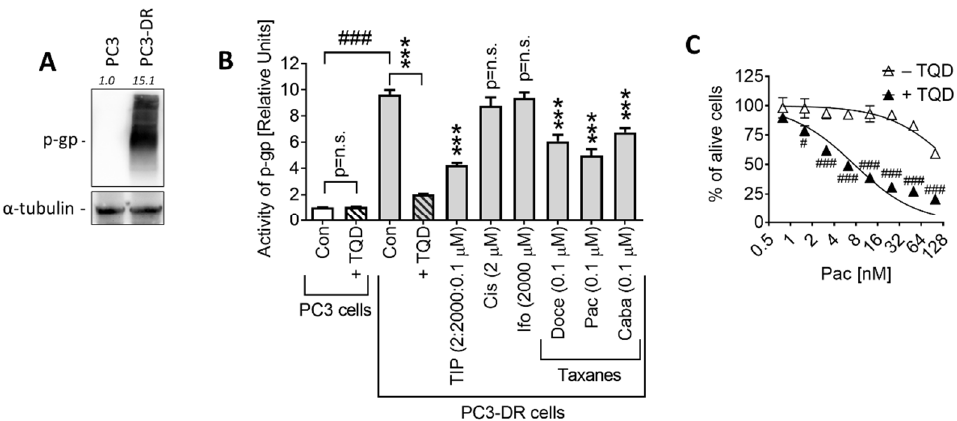
Figure 5. P-gp expression and activity. ( A ), p-gp expression in PC3 and PC3-DR cells was evaluated with Western blotting. ( B ), Effect of the investigated drugs and TIP combinations on the activity of p-gp in PC3-DR cells measured using calcein-AM efflux assay. The observed drop-down of p-gp activity indicates the efflux of the drugs via the p-gp system. ( C ), Viability of PC3-DR cells treated with Pac for 48 h with and without pre-treatment (1 h) with 50 nM tariquidar (TQD, p-gp inhibitor). Cell viability was evaluated using an MTT assay. Statistical analysis: difference between the sample and control: *** p < 0.001 (ANOVA); difference between two samples: # p < 0.05; ### p < 0.001 ( t -test).